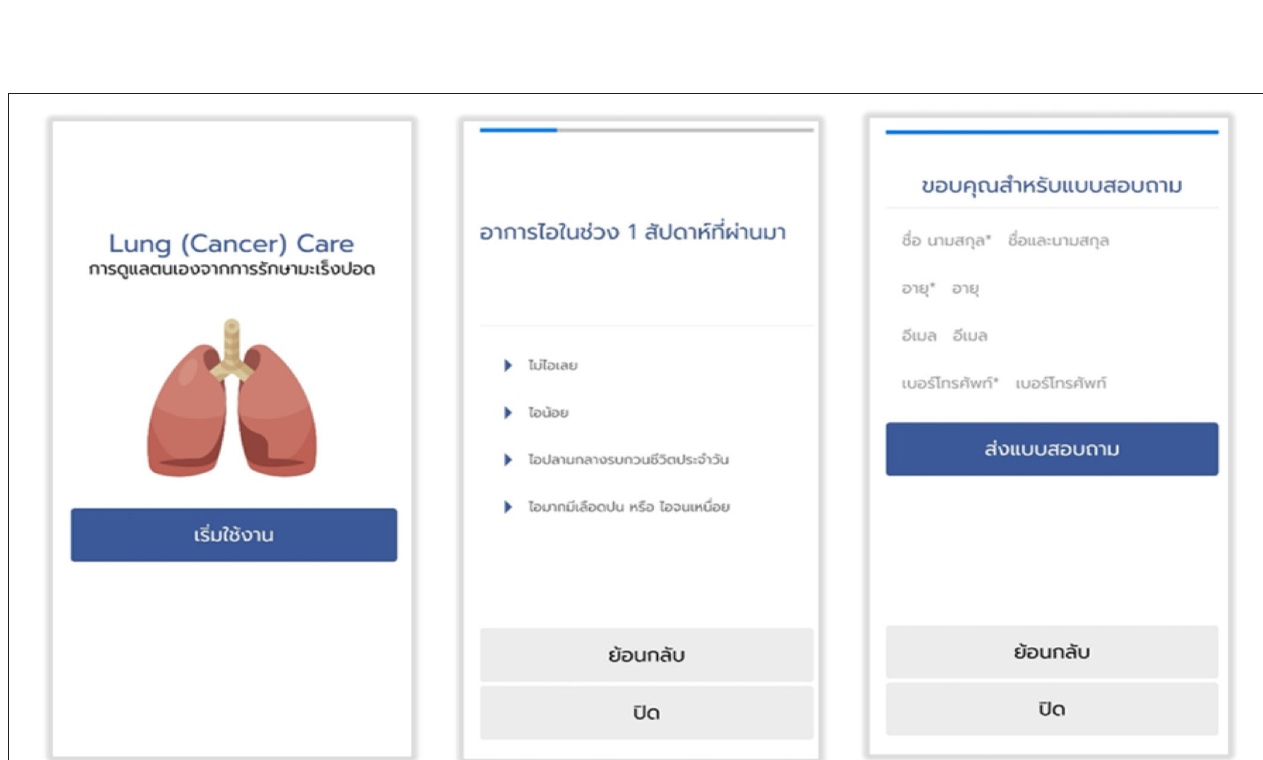
FIGURE 1 | A flow chart of responding toward PRO results.